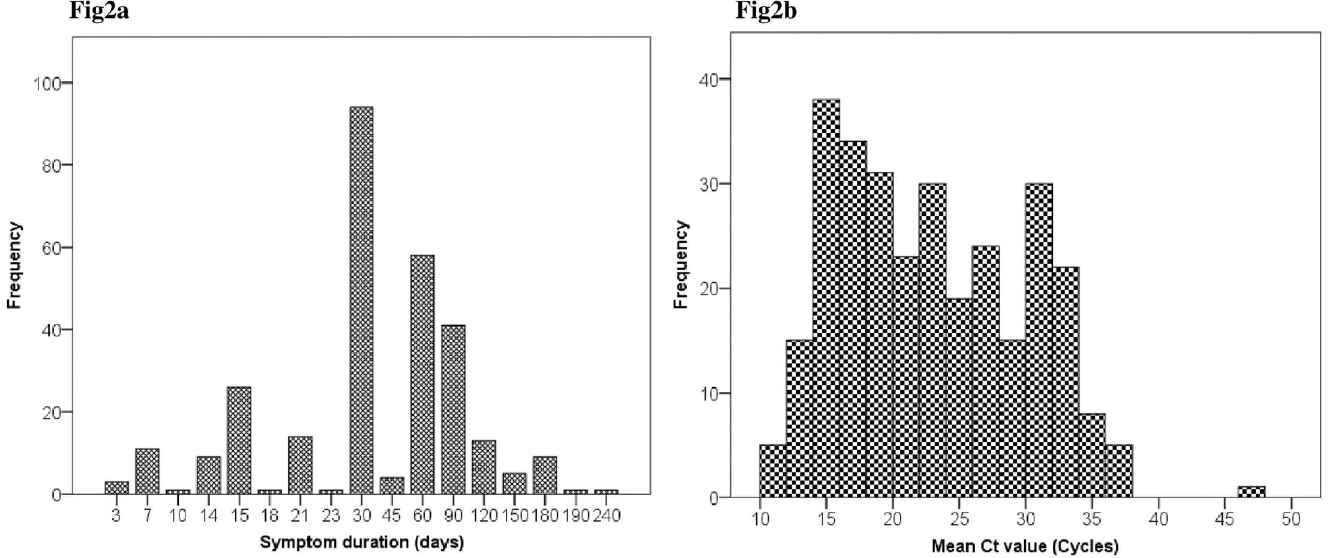
Fig 2. 2a: Distribution of the reportedsymptomduration,Fig2b:Distribution of the XpertmeanCt